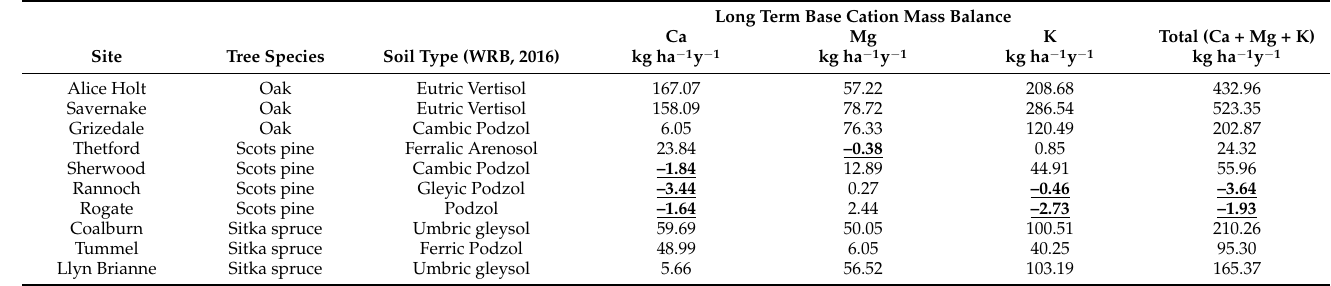
Table 4. Base cation budgets (kg ha − 1 y − 1 ) for each ICP Forest Level II site based on long term (>10 years) monitoring datasets. Mass balances in bold are negative, indicating a net loss of base cations from the forest ecosystem. The Level II sites were not thought to have been fertilised, while the age and/or nature of the woodland plus management made it less appropriate to include base cation inputs from the pre-existing vegetation or enhanced leaching by